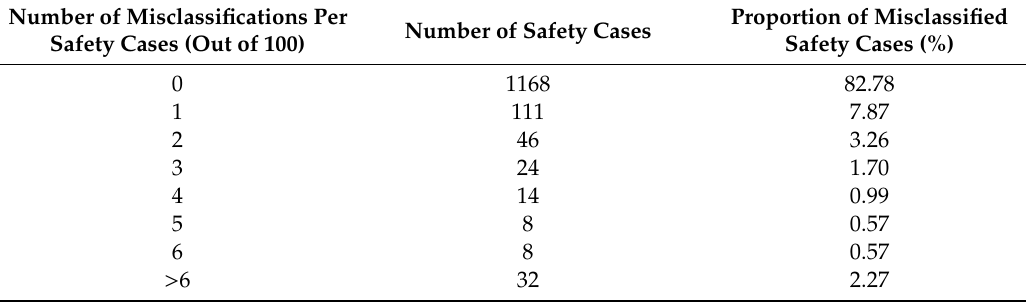
Table 5. Summary of misclassifications for di ff erent